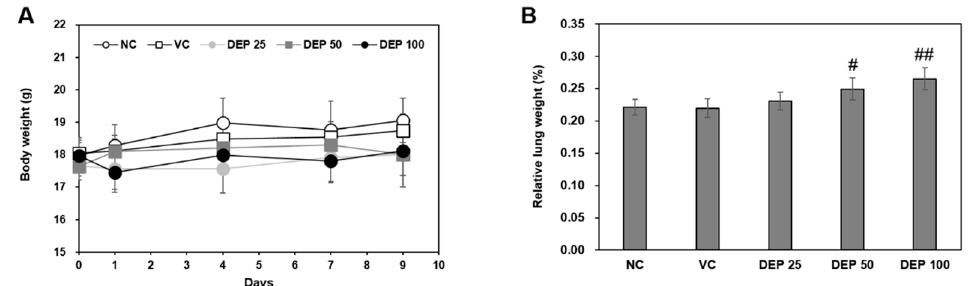
Figure 1. Changes in ( A ) body weight and ( B ) relative lung weight in mice in response to DEP instillation. Relative lung weights were calculated as follows: relative organ weight = lung weight (g) / final body weight (g) × 100%. Data are means ± SD ( n = 5 per group). # p < 0.05 or ## p < 0.01 vs. vehicle control.